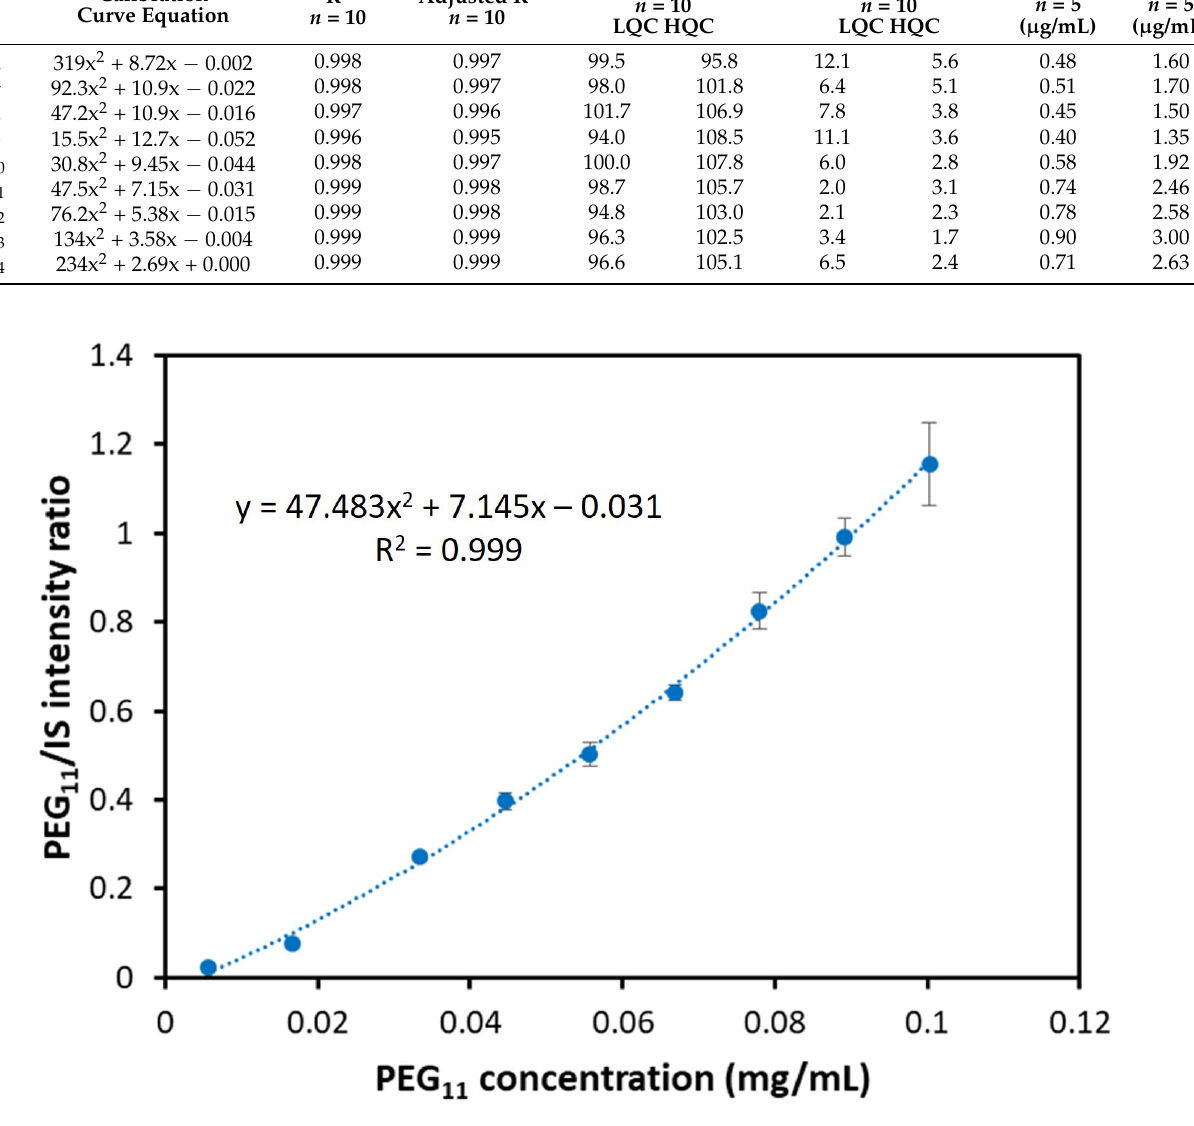
Figure 6. Calibration curve for PEG 11 . The PEG 11 /IS ion intensity ratio is plotted against the PEG 11 concentration. Error bars represent the standard deviation.